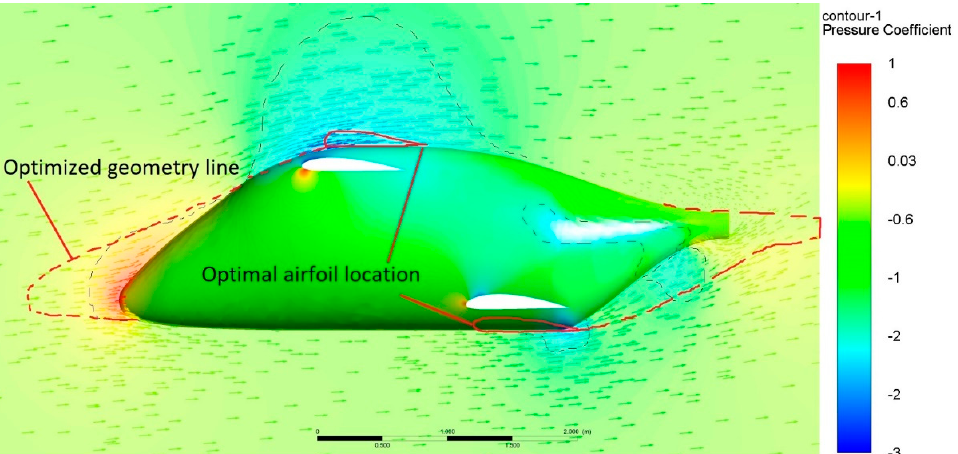
Figure 11. Hypothetical optimized fuselage geometry (nose and aft sections) and airfoil locations based on the flow field at the symmetry section plane.